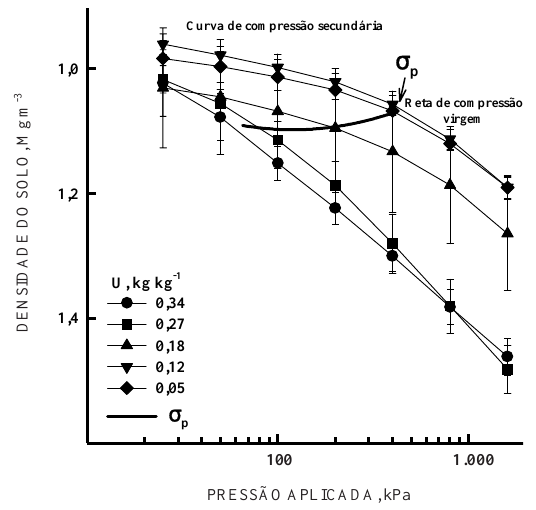
Figura 1. Curvas de compressão médias para o Latossolo Vermelho-Escuro sob cultivo anual, na profundidade de 0-0,03 m, com diferentes umidades gravimétricas (U) (média de três repetições, sendo a barra de erro indicadora do desvio-padrão da